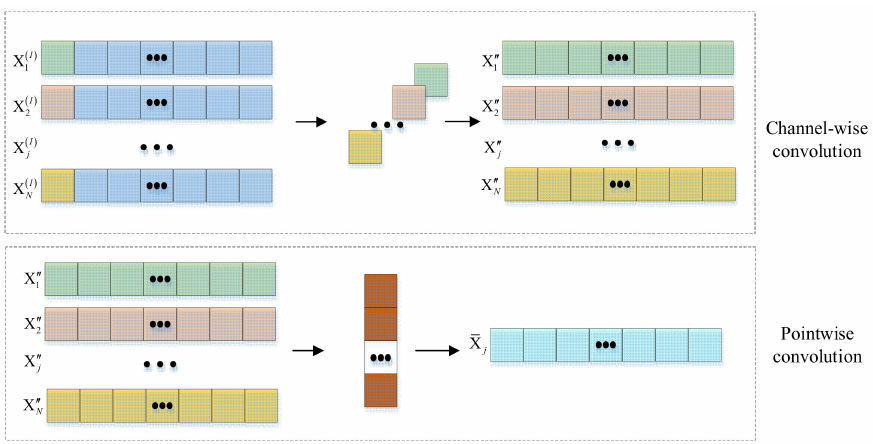
Figure 7. Depthwise separable